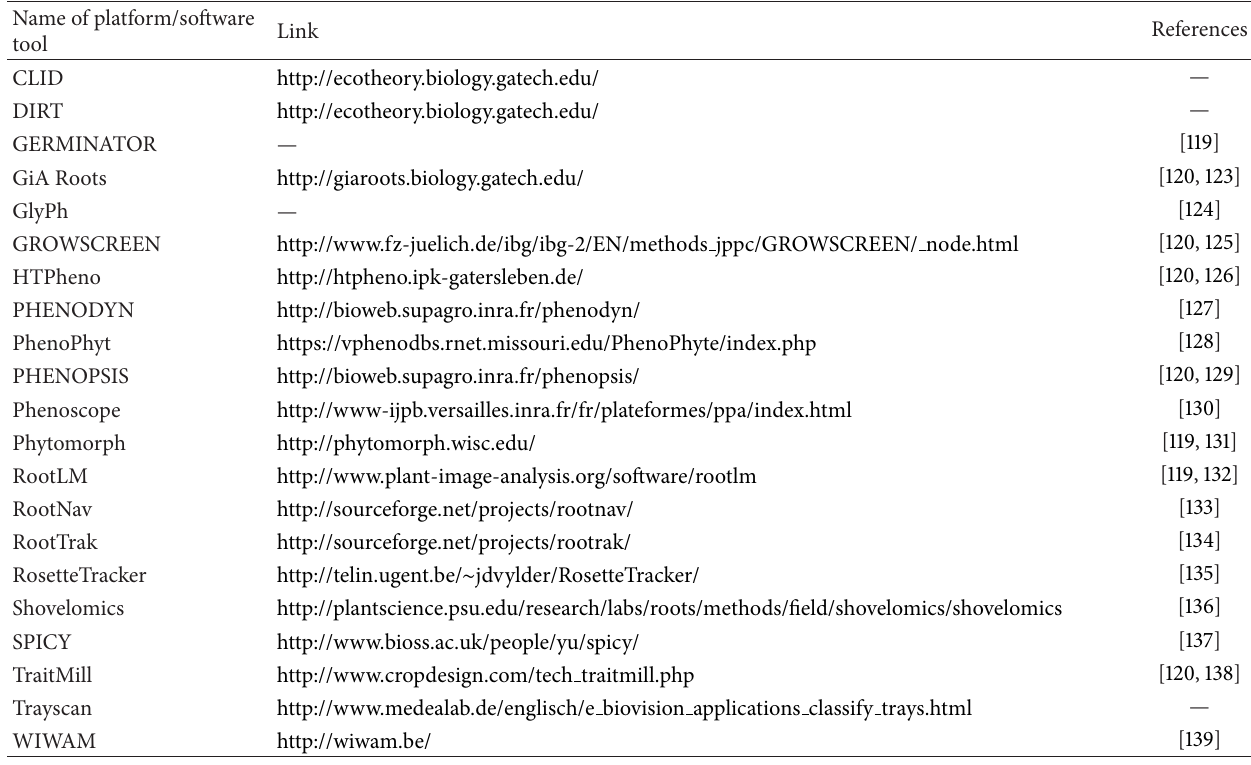
Table 4: List of some recently developed phenotyping platforms/software